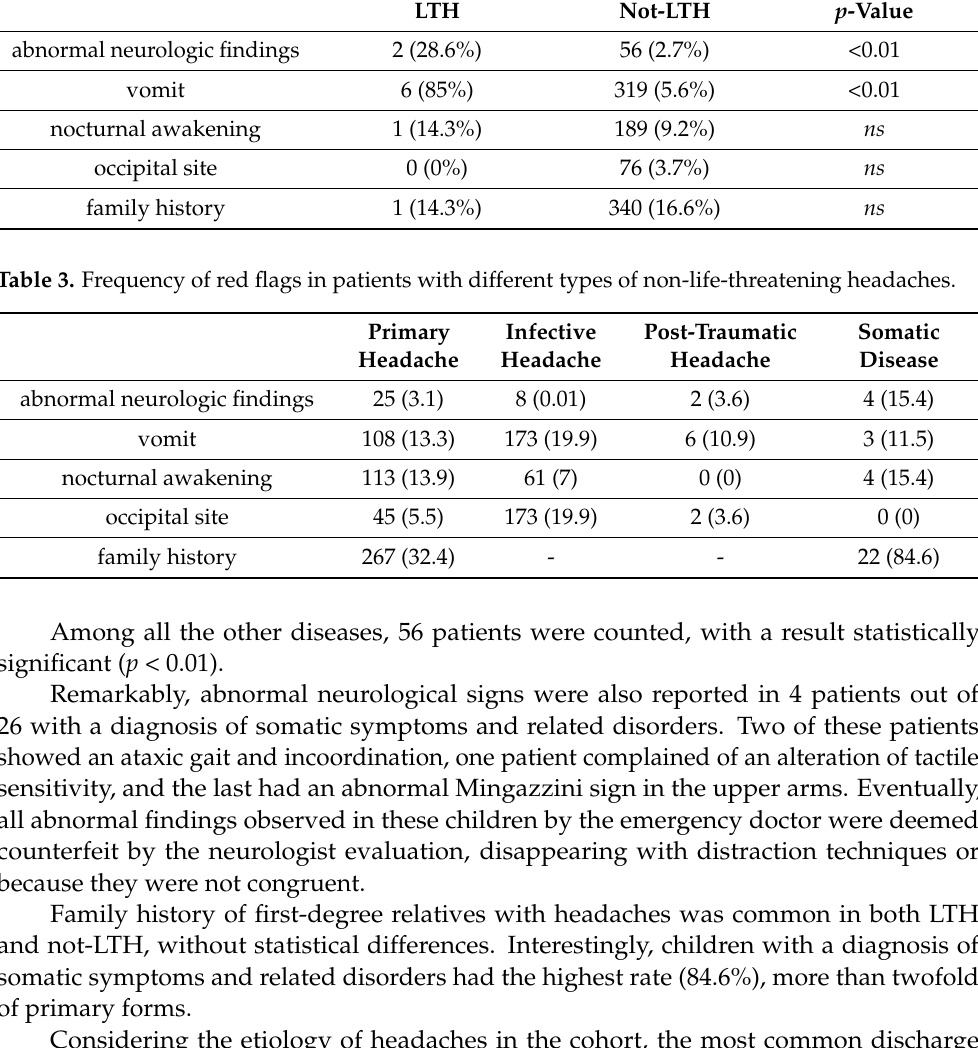
Table 2. Frequency of red flags in patients with or without life-threatening headaches. Red Flags LTH Not-LTH p -Value abnormal neurologic findings 2 (28.6%) 56 (2.7%) <0.01 vomit 6 (85%) 319 (5.6%) <0.01 nocturnal awakening